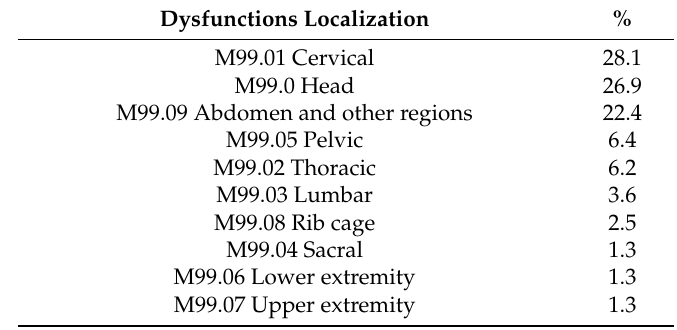
Table 2. Dysfunctions localization reported for the di ff erent body segments in OMTg according to somatic dysfunction classifications.